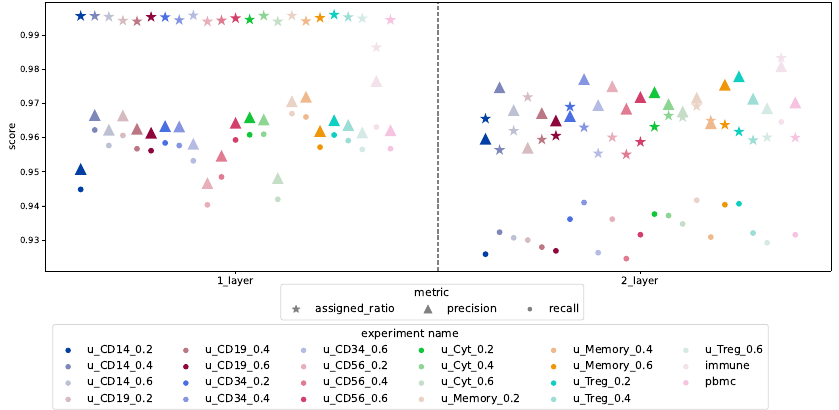
Figure 7. The colors represent the datasets used for testing the performance. In the legend “immune” refers to the Immune experiment, “pmbc” to the balanced PBMC experiment, and u_cell-type_ratio refers to the undersampled version of the PBMC where the “ratio” indicates the proportion of cells of sampled cells a given “cell-type”. Triangles and dots represent the mean across the test sets of the weighted precision and recall scores, respectively, while the crosses resent the mean of the proportion of cells assigned a cell type (since all cells are known, the higher the